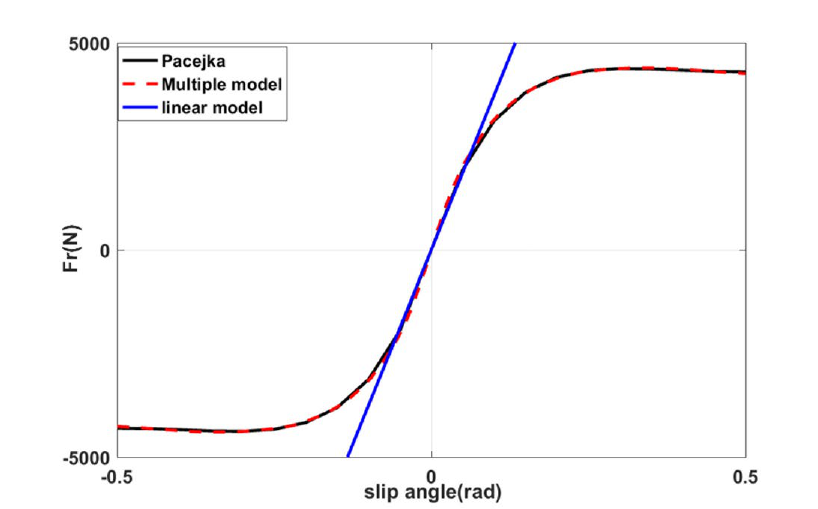
Figure 3. Comparison of Pacejka model and the multiple